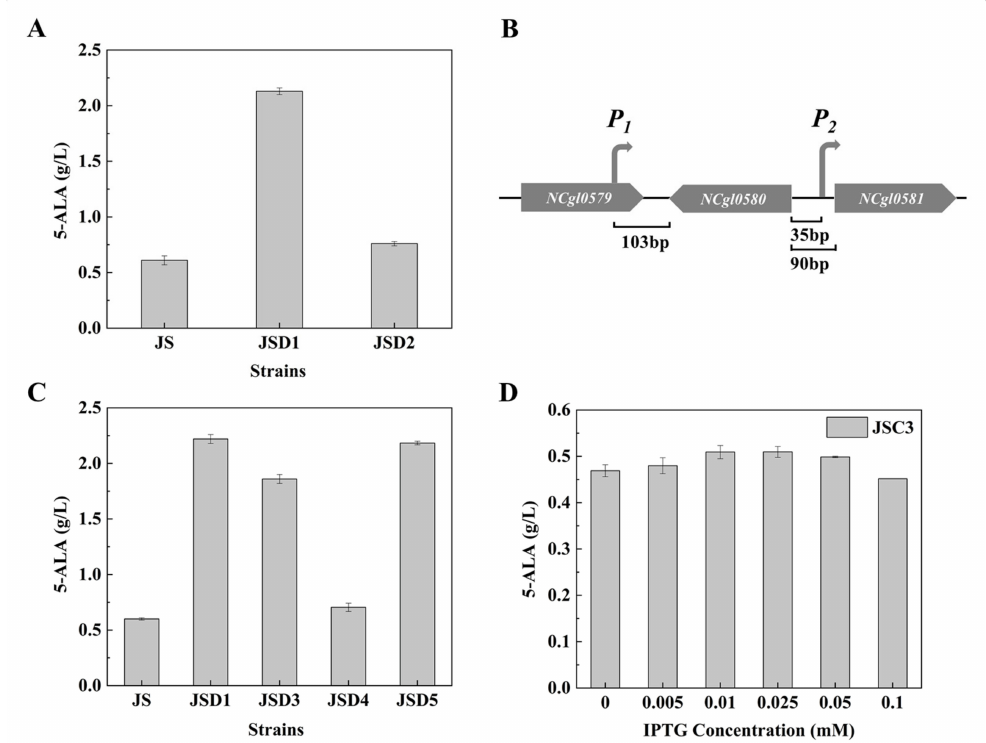
Figure 2. Effects of NCgl0580 , NCgl2065 , and NCgl0581 perturbation on 5-ALA biosynthesis. ( A ) 5-ALA titers of the NCgl0580 and NCgl2065 deletion strains, JSD1 and JSD2, compared to JS (control). ( B ) Distribution of genes up- and downstream of NCgl0580 and predicted promoters (50 bp) in the genome of C. glutamicum . The predicted promoters P1 and P2 received scores of 0.96 and 0.65, respectively, from NNPP, which gives output scores between 0 and 1. A higher score indicates a more accurate prediction. ( C ) 5-ALA titer of strain JSD3 with three TAA termination codons inserted before the 10th, 18th, and 27th amino acids of NCgl0580 and NCgl0581 deletion strain JSD4, as well as the NCgl0580 and NCgl0581 double knockout strain JSD5, and control strains JS and JSD1. ( D ) 5-ALA titer of NCgl0581 overexpression strain JSC3 induced with different isopropyl thiogalactoside (IPTG) concentrations. The error bars represent the standard deviations from three independent